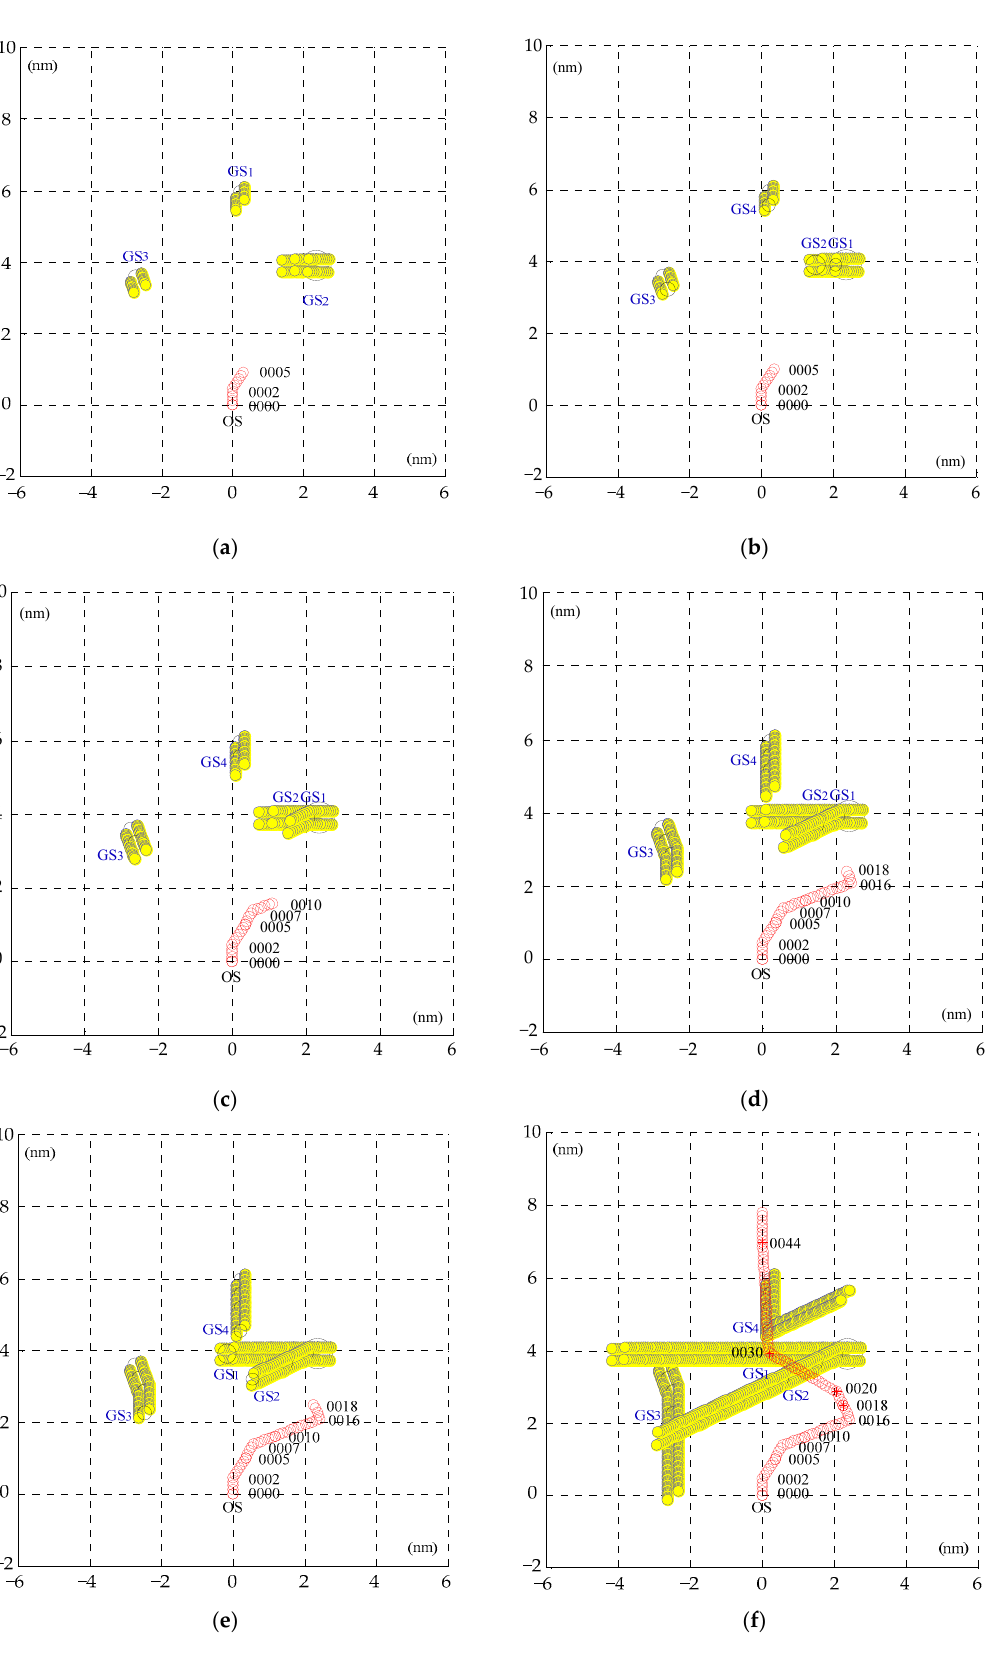
Figure 7. Simulation results: ( a ) Ship trajectories (0000–0005); ( b ) distribution of target ships and group ships at 0005; ( c ) ship trajectories (0000–0010); ( d ) ship trajectories (0000–0018); ( e ) distribution of target ships and group ships at 0018; ( f ) ship trajectories (0000–0044).